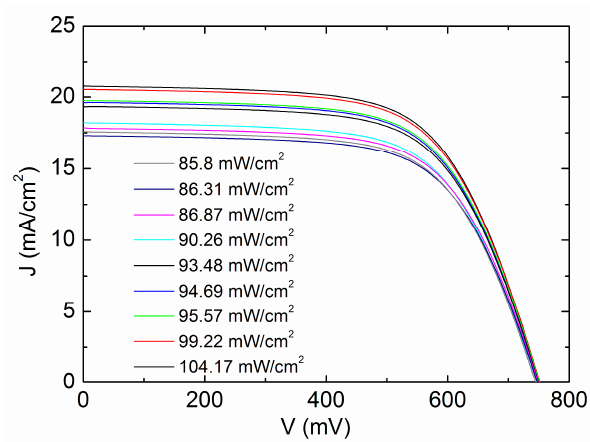
Figure 1. J–V curves between 85.8 mW / cm 2 and 104.17 mW / cm 2 with cell #1.